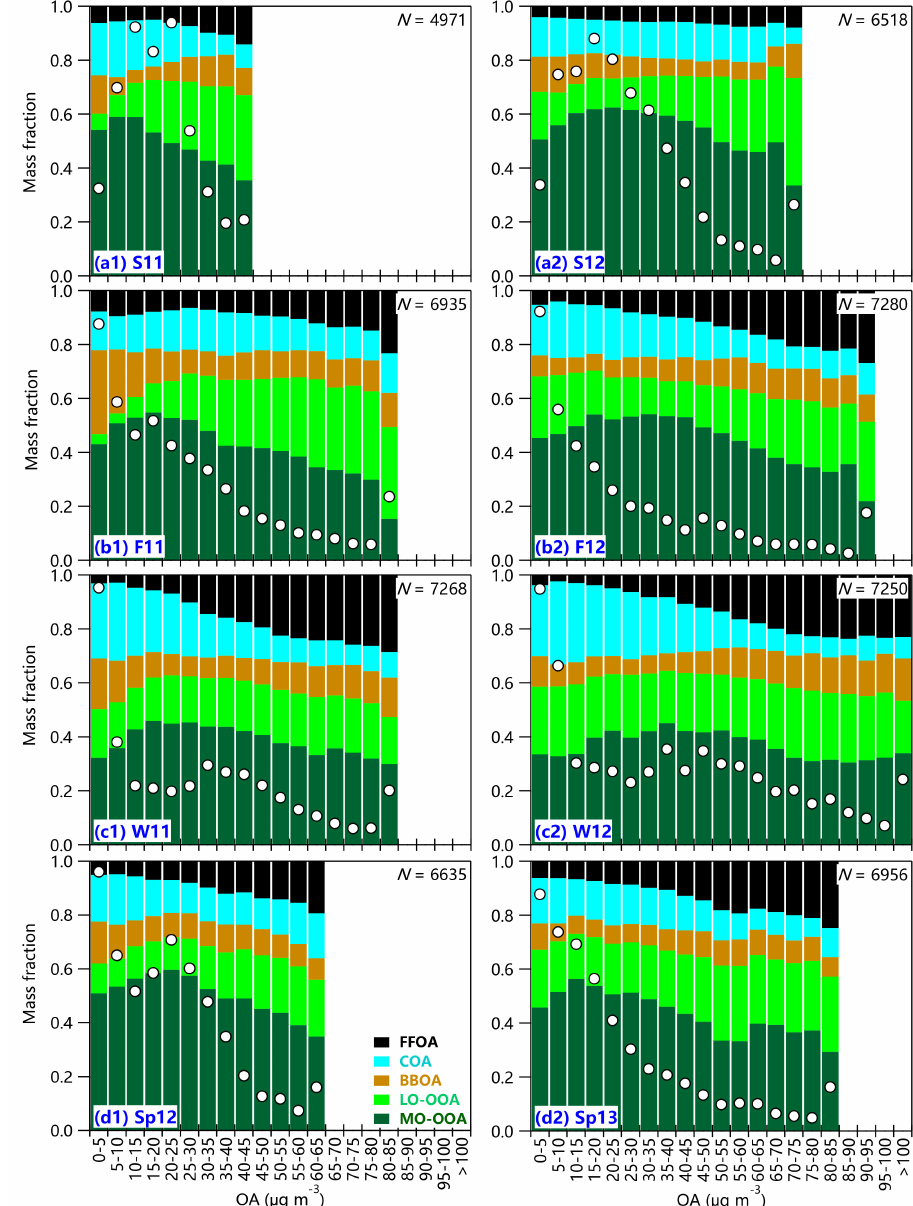
Figure 5. variations in OA composition as a function of OA mass loadings during four seasons. The data are grouped in OA bins (5µgm − 3 increment). The white circles indicate the frequency of each OA bin, and the total number of points ( N ) for each season is also